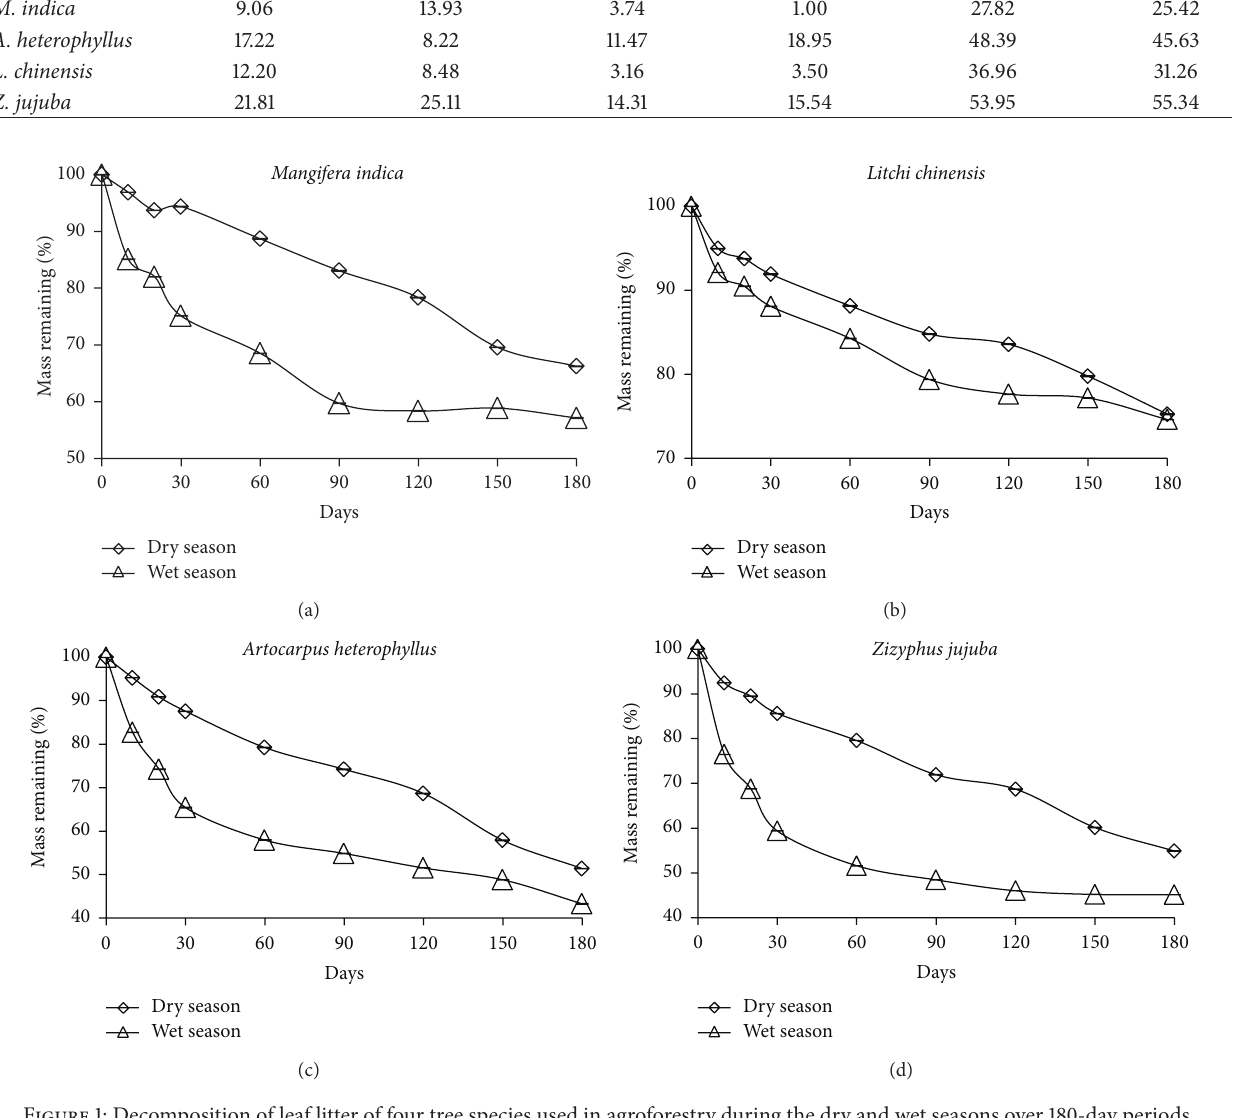
Figure 1: Decomposition of leaf litter of four tree species used in agroforestry during the dry and wet seasons over 180-day